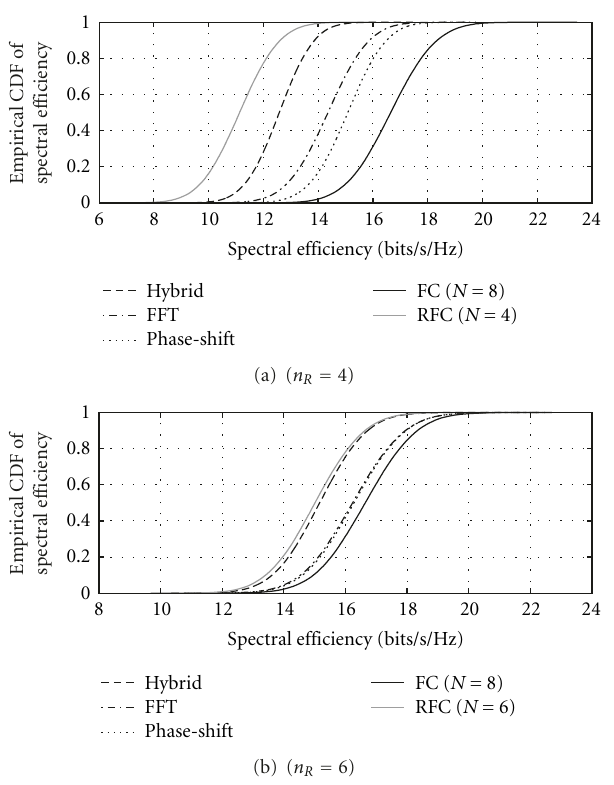
Figure 11: Empirical CDF of the spectral e ffi ciency of a compact MIMO system with AS. M = 5, N = 8, and mutual coupling is not